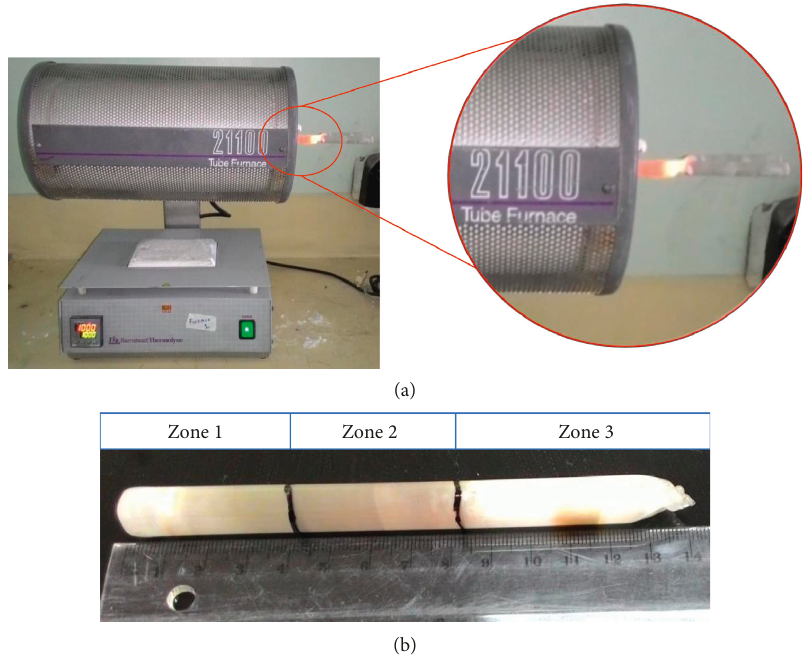
Figure 1: (a) Horizontal furnace. (b) Quartz tube after baking.